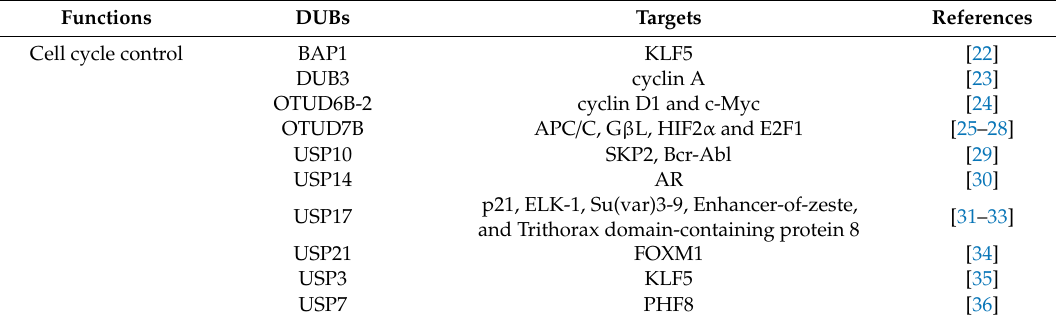
Table 2. Functional roles of DUBs in cancer